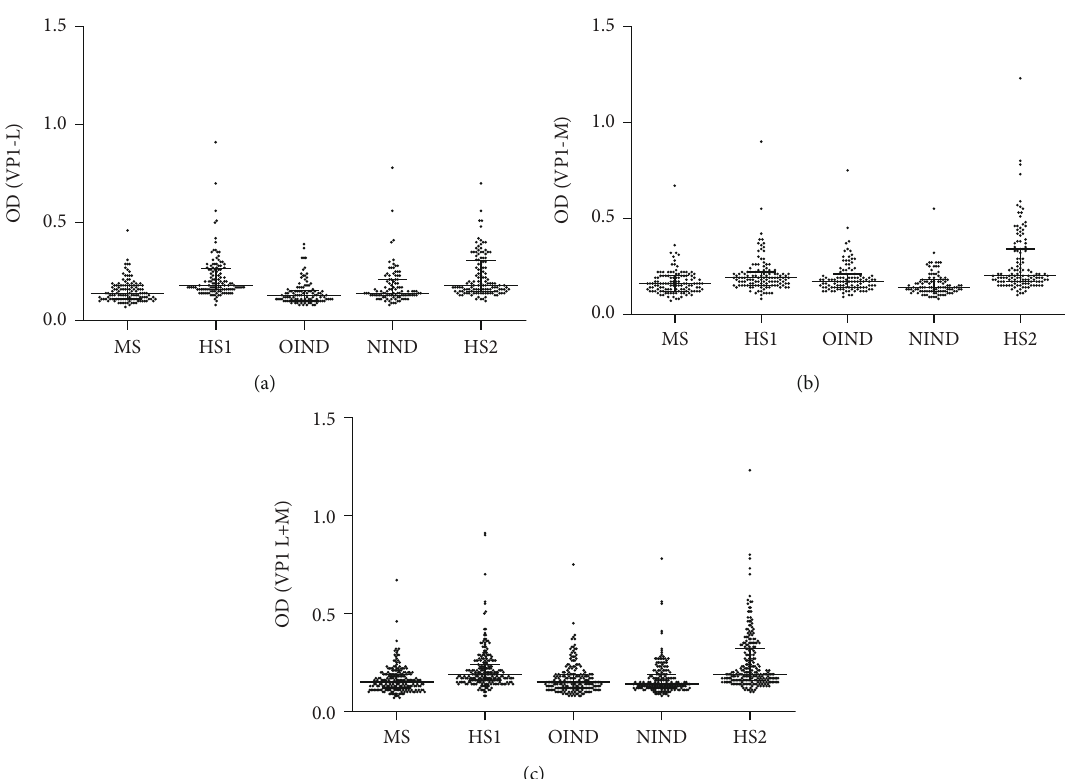
Figure 2: Serologic pro fi le. Serologic pro fi le of serum antibody reactivity (OD) to BKPyV mimotopes VP1 L (a) and VP1 M (b) and VPs L +M (c). (a) In ELISAs with VP 1 L peptide, the mean OD of sera ( mean ± SEM ) in MS ( 0 : 15 ± 0 : 06 ) were statistically signi fi cant lower